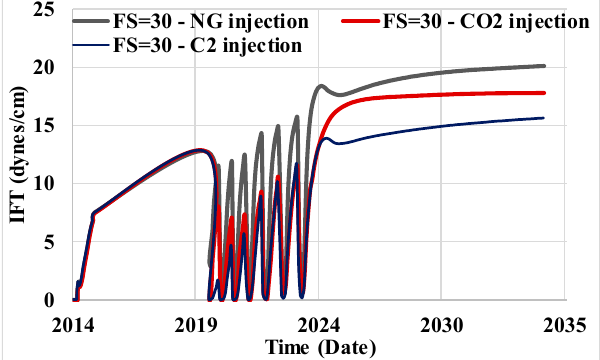
Figure 7. IFT during natural depletion (ND) and CGI by CO 2 , C 2 H 6 and NG, Oil API=38°.